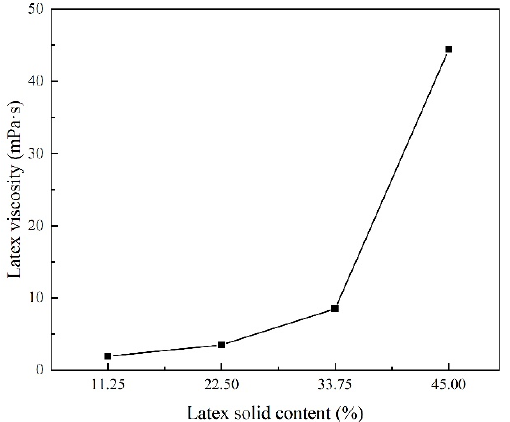
Figure 4. The dependence of the XNBR latex viscosity on the solid content, with content levels ranging from 11.25 wt% to 45.00 wt%.